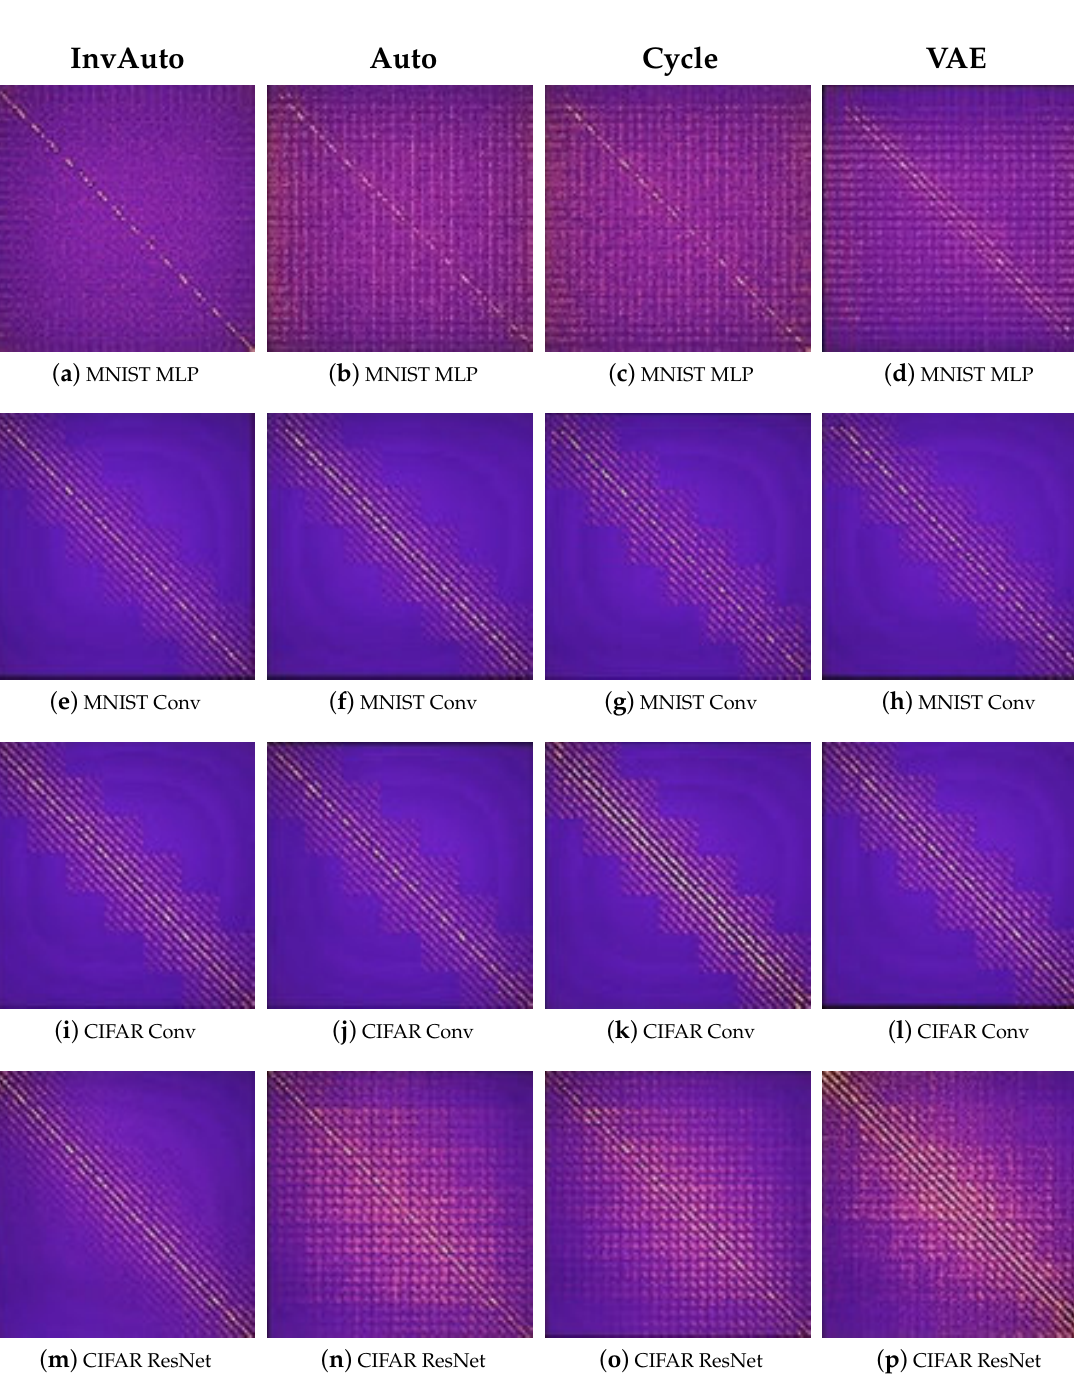
Figure A4. Heatmap of the values of matrix DE for InvAuto, ( a , e , i , m ) Auto ( b , f , j , n ), Cycle ( c , g , k , o ), and VAE ( d , h , l , p ) on MLP, convolutional (Conv), and ResNet architectures and MNIST and CIFAR datasets. Matrices E and D are constructed by multiplying the weight matrices of consecutive layers of encoder and decoder, respectively. In case of InvAuto, DE is the closest to the identity